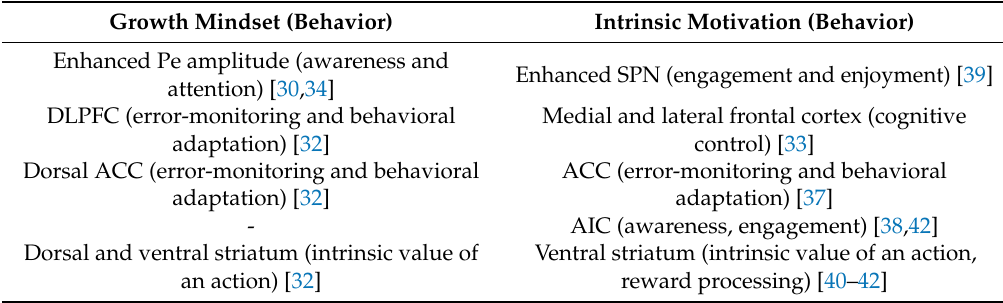
Table 1. Neuroscientific evidence of growth mindset and intrinsic